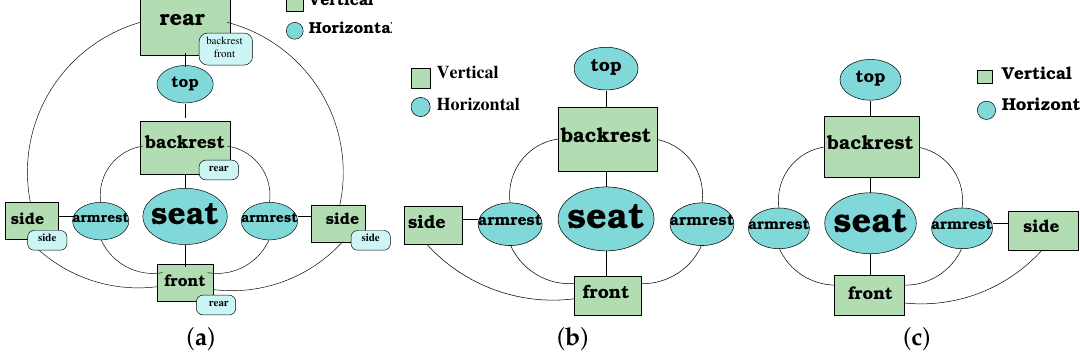
Figure 12. In ( a ), the graph corresponding to the complete couch graph, and in ( b , c ), two sub-graphs for the front left and right